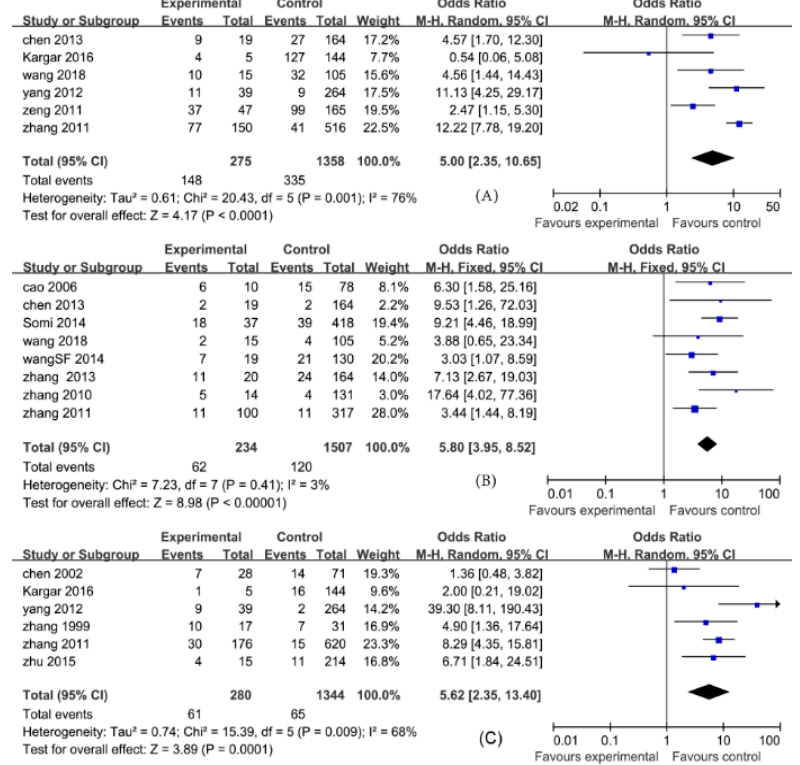
Figure 2. Effects of pooled odds ratios (ORs) for factors correlating to the development of hepatitis C virus infection in hemodialysis patients (( A ) shared hemodialysis devices; ( B ) kidney transplantation; ( C) : serum alanine aminotransferase levels (abnormal)).